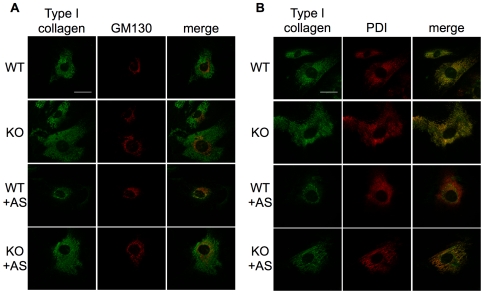
Abnormal localization of collagen in CypB–deficient cells.MEFs prepared from wild-type (WT) or CypB knockout mice (KO) were cultured with or without 24hr stimulation with ascorbic acid (+AS). Cells were fixed, permeabilized, and co-stained for intracellular collagen and the Golgi marker GM130 (A) or the ER-resident protein PDI (B). (bar = 40 µm).